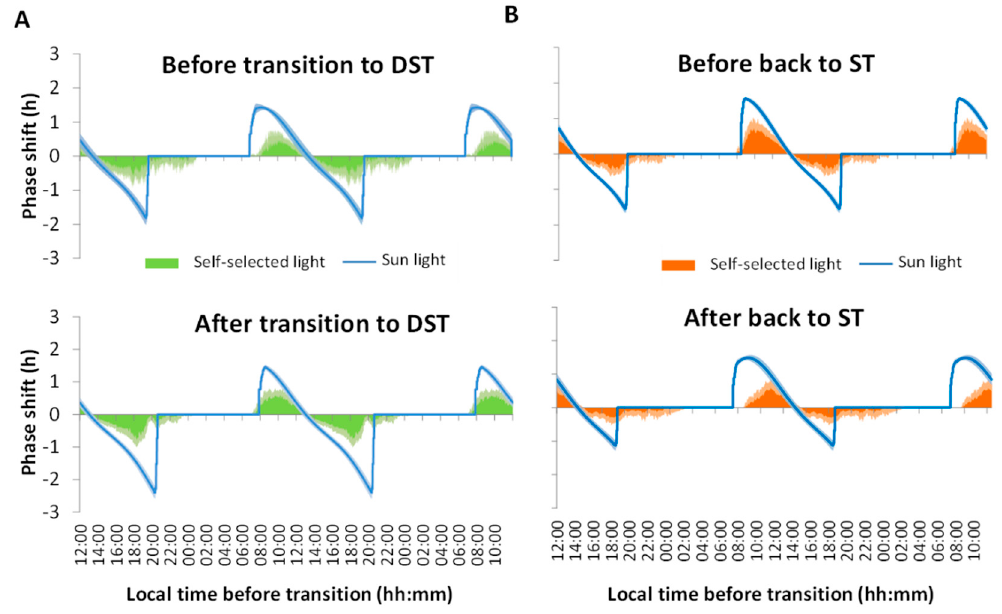
Figure 5. Average theoretical phase advance and phase delay areas under the curve ( n = 8) before and after DST transition ( A ) and before and after returning to ST ( B ), based on self-selected light exposure (in green) or solar light (in blue) for the corresponding time of the year, centering the circadian phase 0 h on the TM5 for WT of each participant. See the Section 2 for details. Data are expressed as the mean ± SEM.